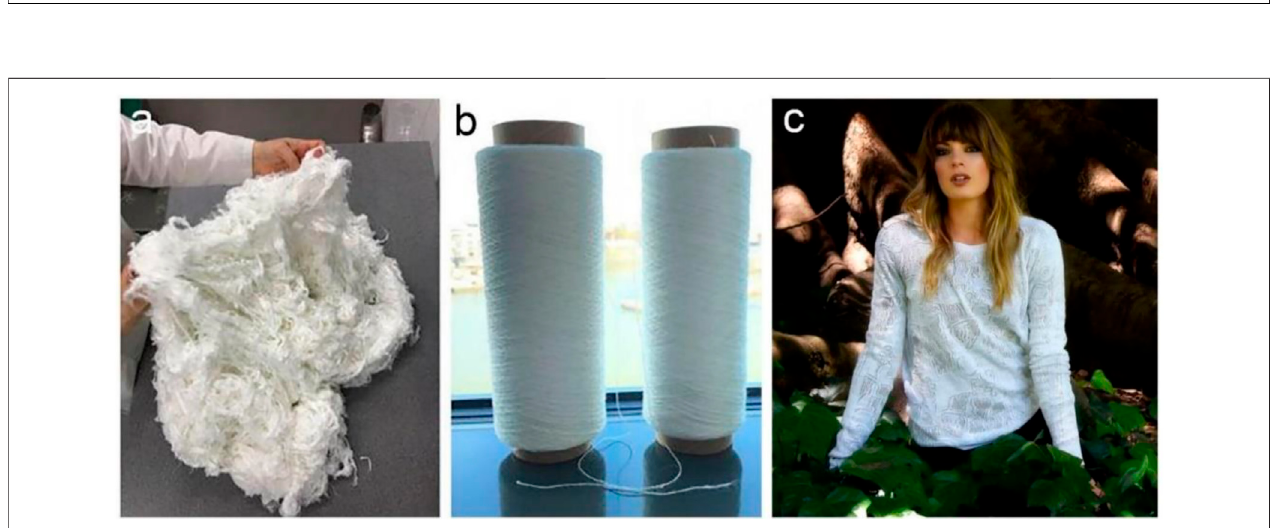
FIGURE10| NanollosemakesNullarborTM fi bre (A) ,yarn (B) ,garmentsfromtree-freeviscoserayon fi bre (C) .ReprintedwithpermissionfromZhong(2020)under Creative Commons Attribution License (CC BY).